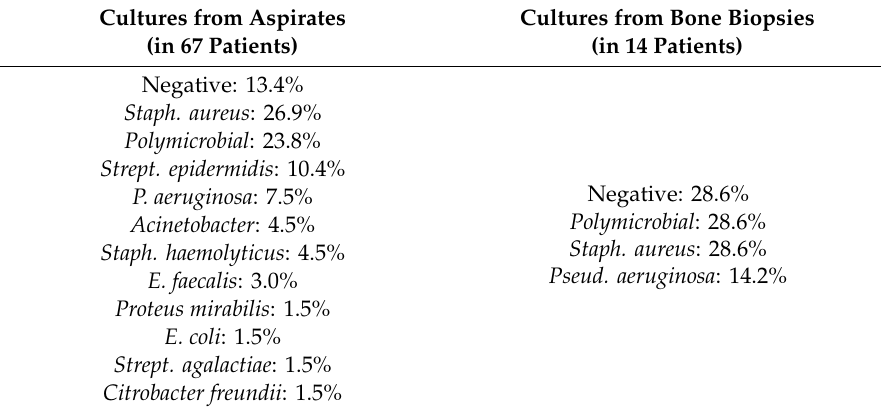
Table 2. Microbiology and histopathological findings.